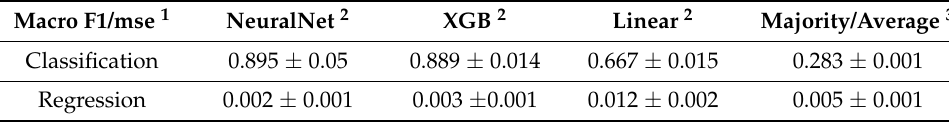
Table 3. Machine learning model accuracy comparison